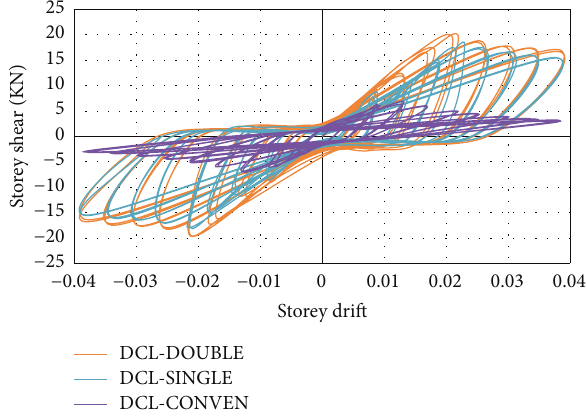
Figure 15: Experimental comparison of hysteresis performance of all three specimens.